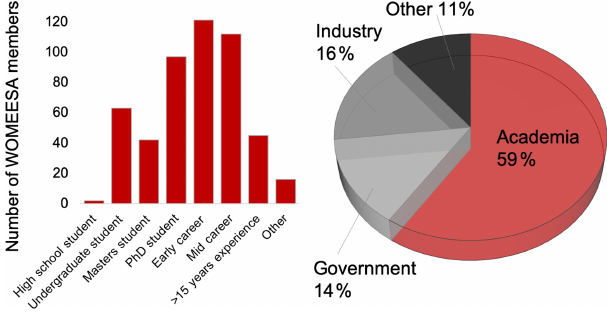
Figure 6. Career stage and area of employment of the 458